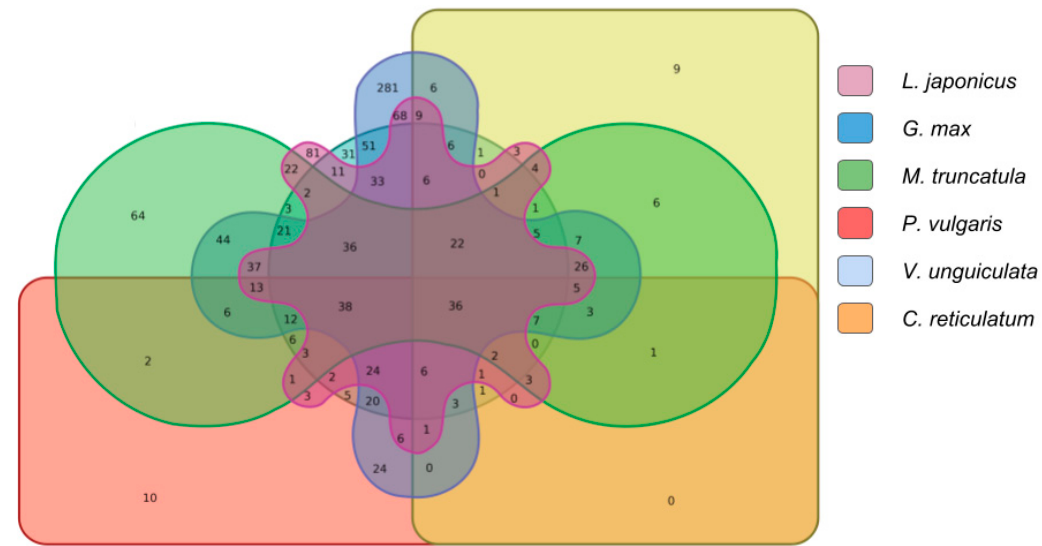
Figure 7. Total transcripts aligned to Fabaceae genomes and transcriptome: This diagram shows the amount of copaíba lncRNA aligned to the both genome and transcriptome of each species segregated by a color pattern indicated in the legend. In the colored overlapped area are the transcripts which were aligned to more than one species genome and transcriptome, and its respective amount.